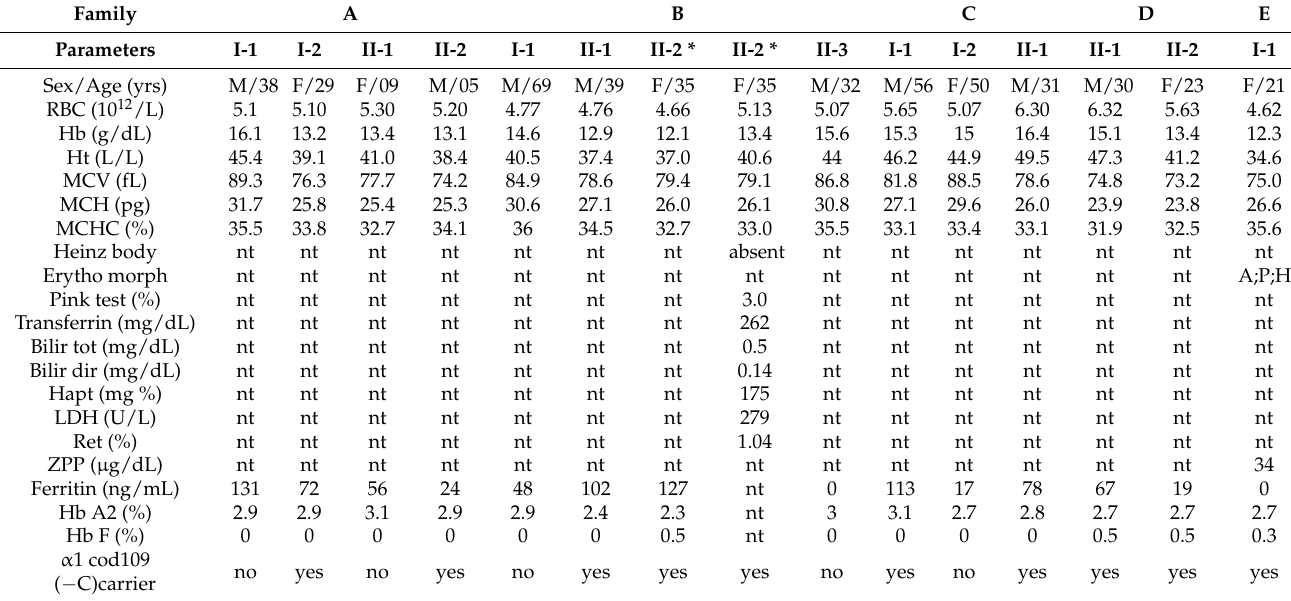
Table 3. Hematological and biochemical data and α -globin genotype of the family with Hb Sciacca .